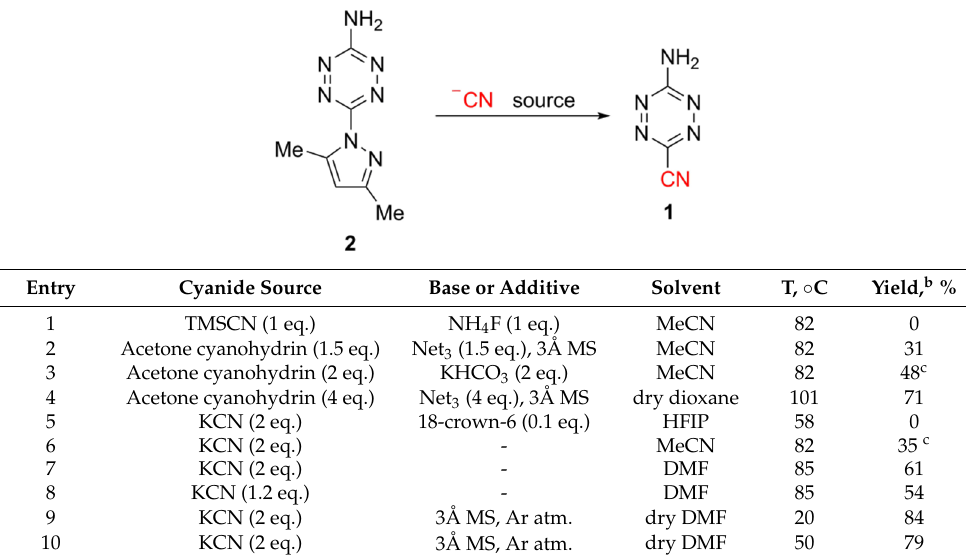
Table 1. Optimization of the reaction conditions for the synthesis of 1 .